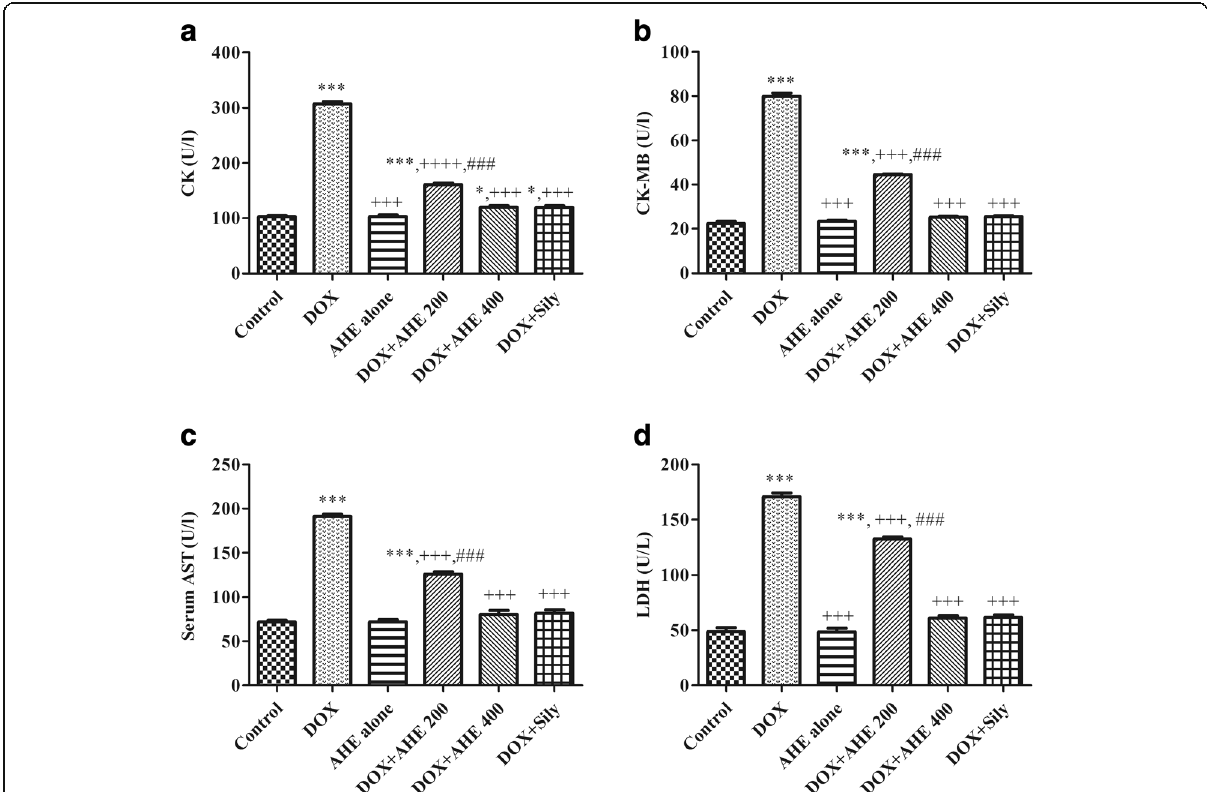
Fig. 1 Effect of AHE treatment on serum markers of cardiac injury. a CK, ( b ) CK-MB, ( c ) AST, ( d ) LDH. Data are represented mean ± S.E.M ( n = 6). Asterisks *, **, *** indicates p < 0.05, 0.001, 0.0001 vs. control; +, ++, +++ indicates p < 0.05, 0.001, 0.0001 vs. DOX; #, ##, ### indicates p < 0.05, 0.001, 0.0001 vs. AHE (200 mg/kg